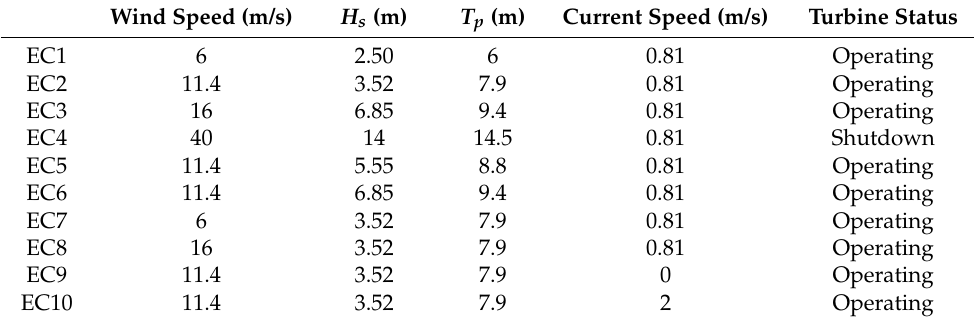
Table 5. Environmental conditions.